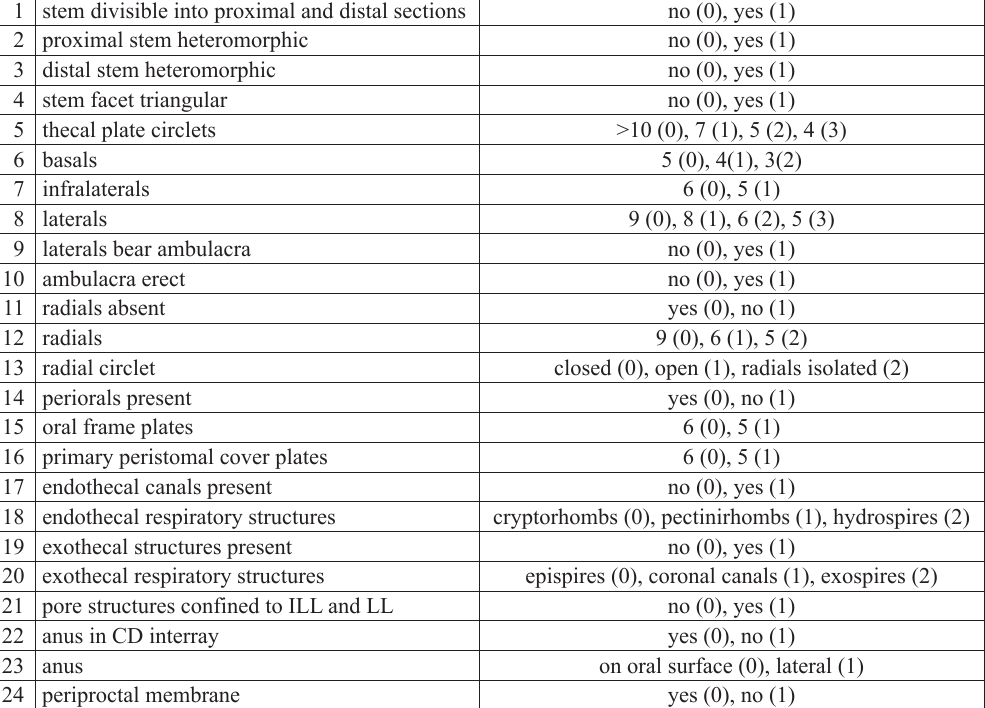
Table 3. Characters and coding of character